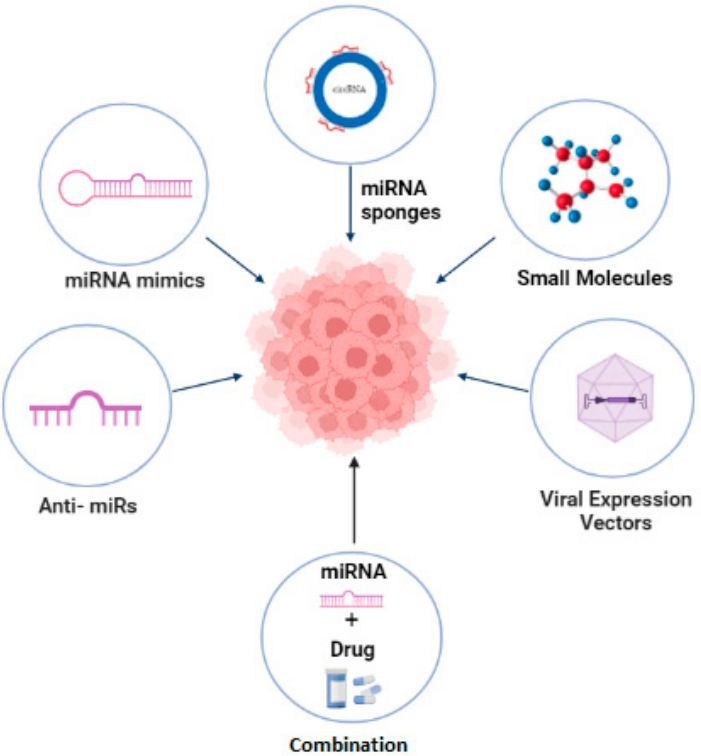
Figure 3. miRNA therapeutics in modulation of tumor associated miRNA expression in cancer.